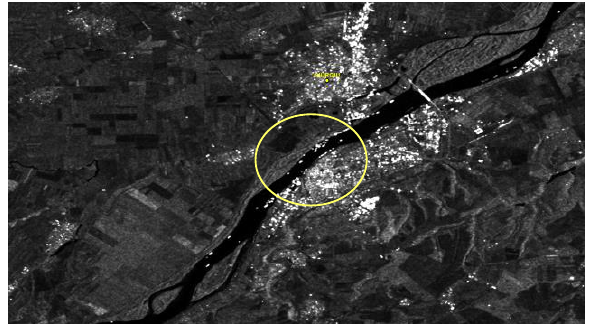
Figure 7. Giurgiu Harbour – 09.08.2015 -